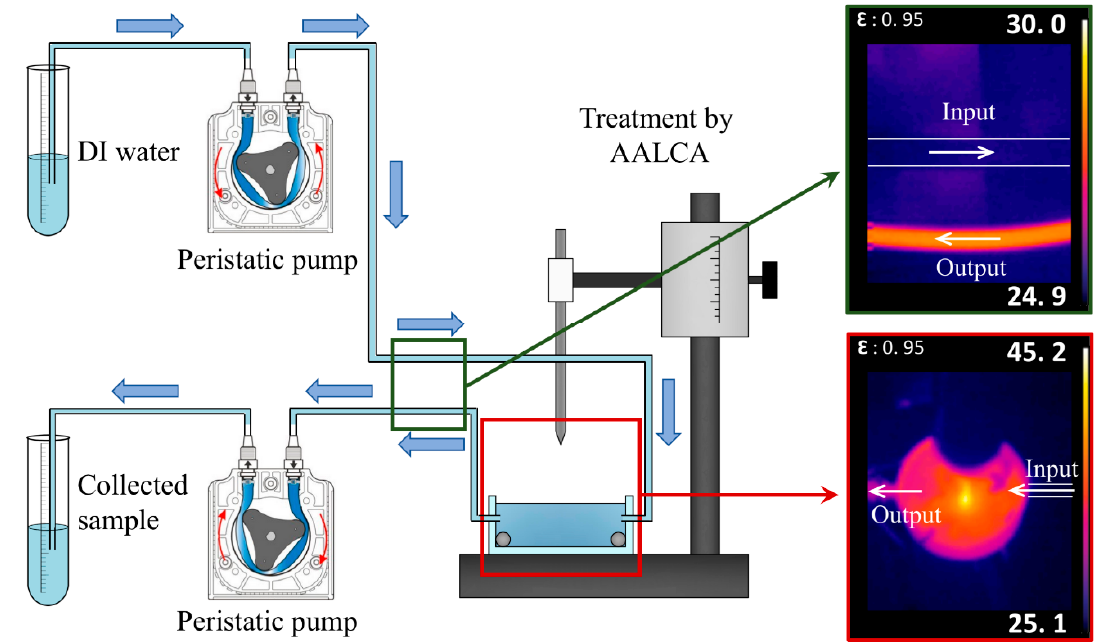
Figure 10. Schematic of experimental setup for treatment of continuous flow of liquid, thermographic image of flowing DI water treated with AALCA (right, bottom), and comparison of water temperatures in tubes before and after treatment (right, top).